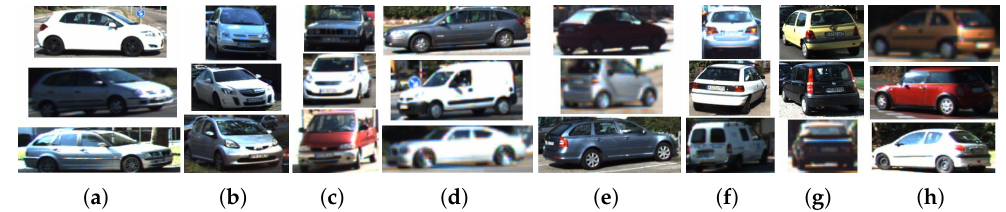
Figure 4. Vehicle samples of various orientations, thus various aspect ratios. Each group corresponds to a unique orientation range; ( a ): 0 ∼ π ∼ 7 π ∼ 3 π ( f ): 3 π ; ( g ): 5 π ; ( h ): π ∼ 5 π 2 2 4 4